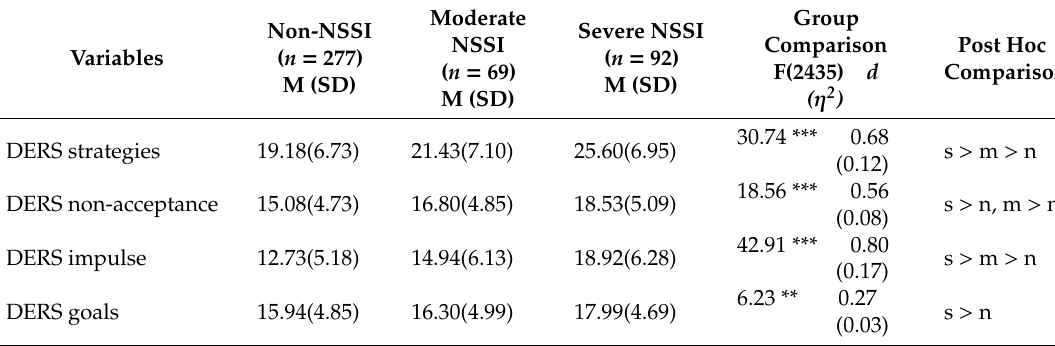
Table 3. Comparison of the means of variables of interest between